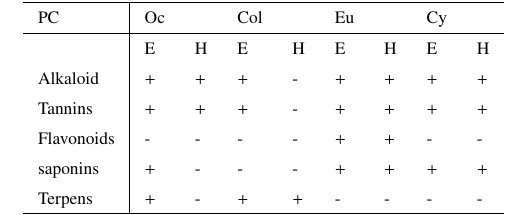
Table 1. The phytochemical constituents (PC)of ethanol (E) and hexane (H) leaf extracts from the studied four plants. PC Oc Col Eu Cy E H E H E H E H Alkaloid + + + - + + + + Tannins + + + - + + + + Flavonoids - - - - + + - - saponins + - - - + + + + Terpens + - +